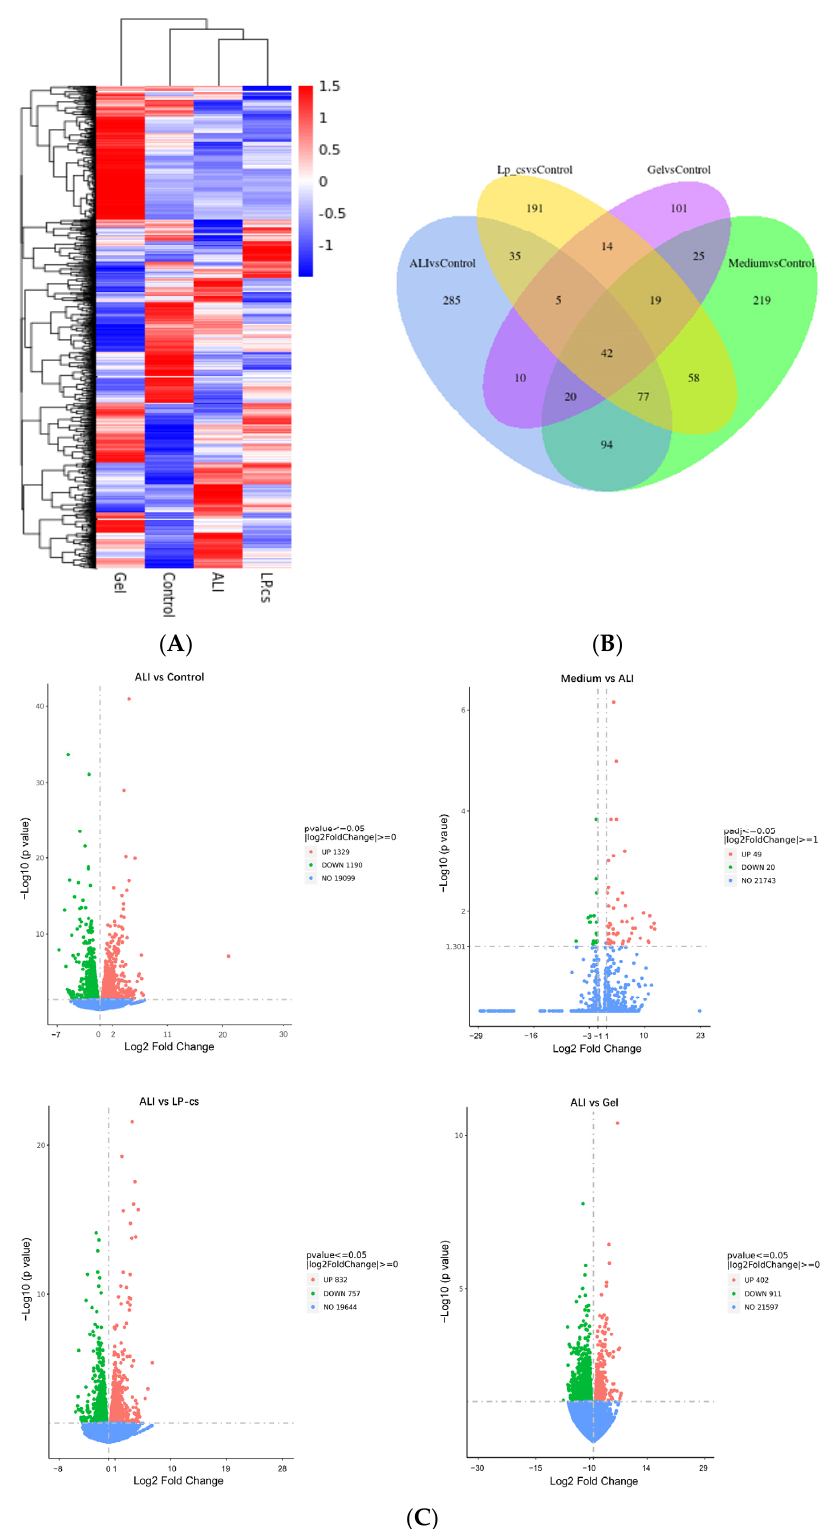
Figure 5. Transcriptomics analysis of liver tissues: ( A ) Heat cluster of gene expression; ( B ) Venn diagram; ( C ) volcano maps. n = 3 per group. Table 2. Up- or downregulation in KEGG and GO enrichment (top 5).